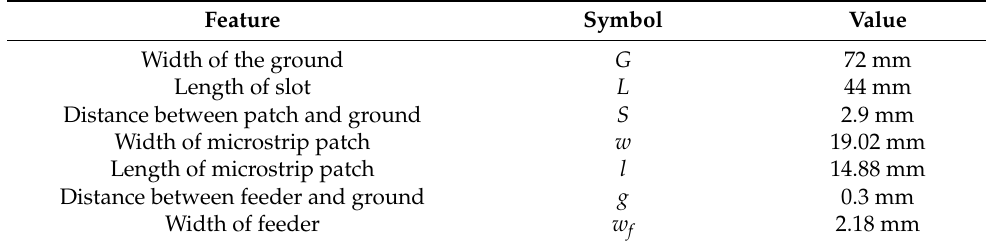
Table 1. Structure size of this antenna.